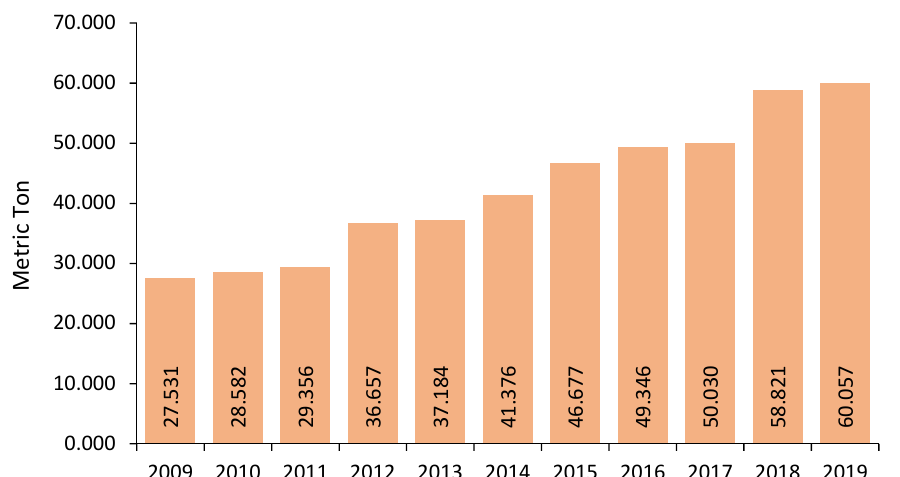
Figure 1. Global production of macadamia nut (2009–2019). Adapted from: International Nut and Dried Fruit Council [7].